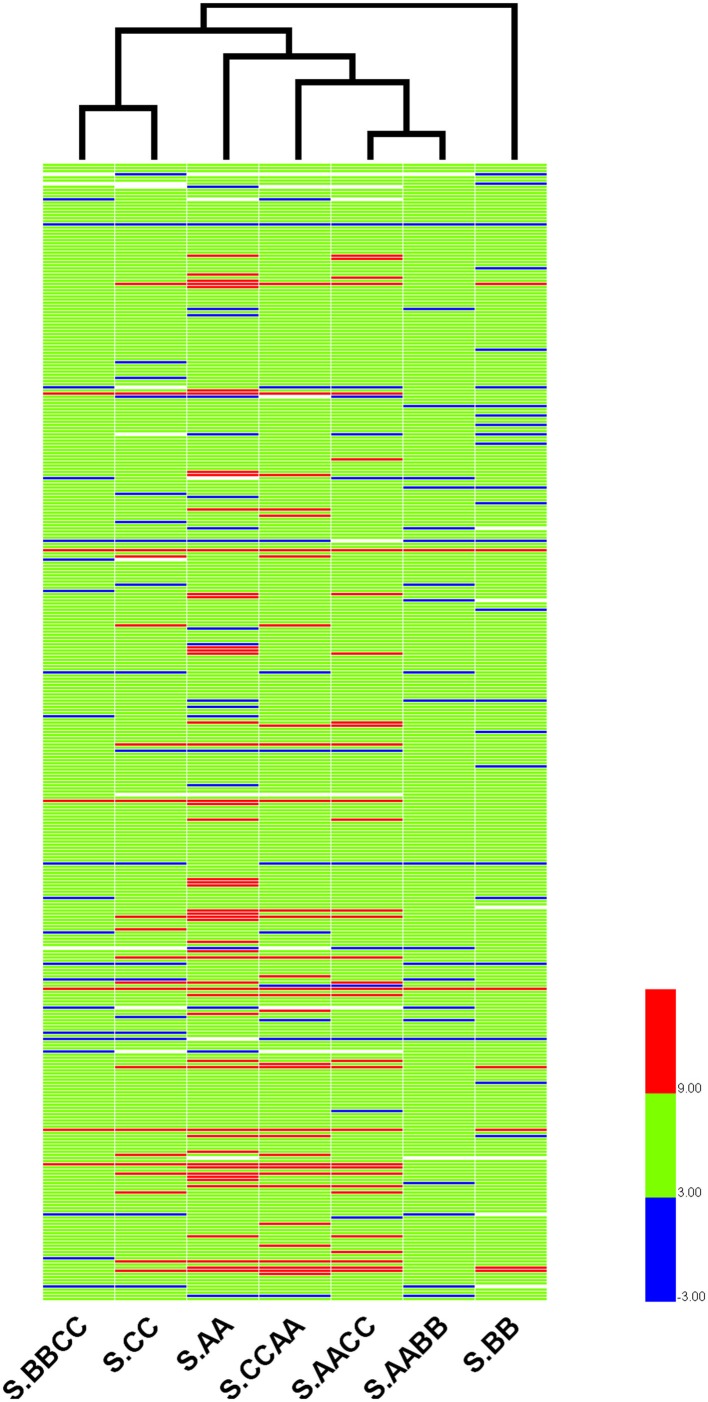
Hierarchical clustering of r-protein genes among allotetraploids and diploids in silique walls.